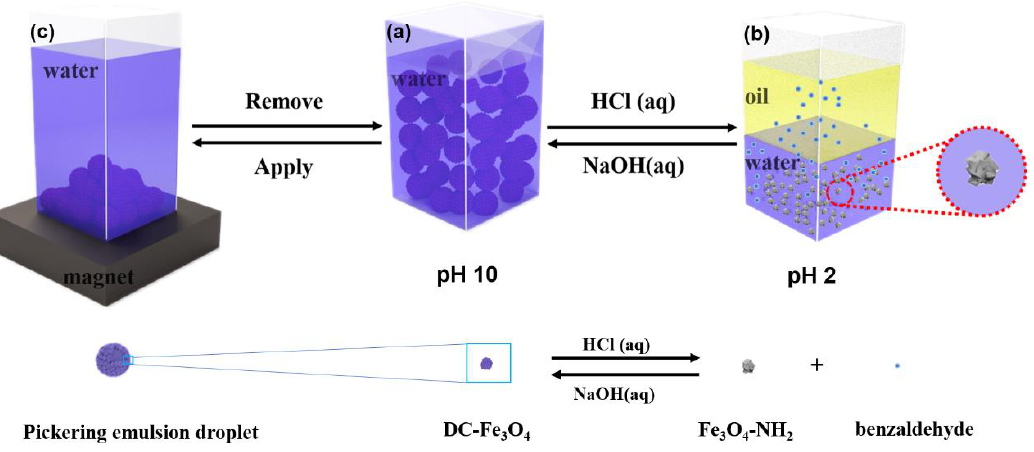
Scheme 1. Illustration of pH and magnetism dual-responsive Pickering emulsion stabilized by DC- Fe 3 O 4 nanoparticles. ( a ) Stable Pickering emulsion, ( b ) phase separated system after decreasing pH